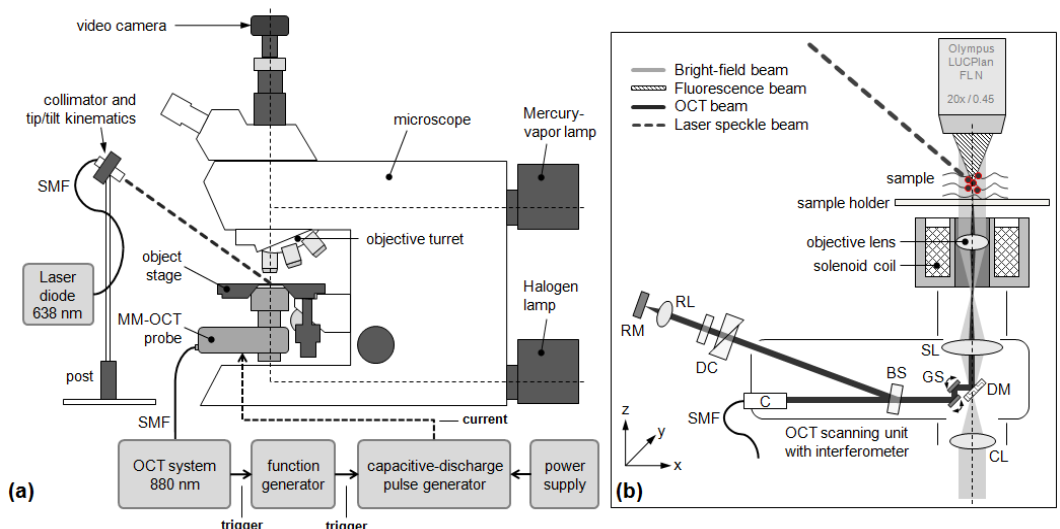
Figure 1. Multimodal imaging setup for magnetomotive OCT (MM-OCT), laser speckle reflectometry and light microscopy. ( a ) Light microscope with integrated MM-OCT probe and dark-field laser illumination for laser speckle imaging. The microscope is equipped with a halogen lamp for bright-field transmission imaging and a mercury-vapor lamp for epi-fluorescence imaging; ( b ) the inset shows a detailed view of the sample region and the OCT scanning unit with attached electromagnet. The coordinate system ( x , y , z ) indicates the orientation of the MM-OCT probe. The x -direction is the fast scanning direction of the OCT probe. Hence, cross-sectional OCT images (tomographic B-scans)